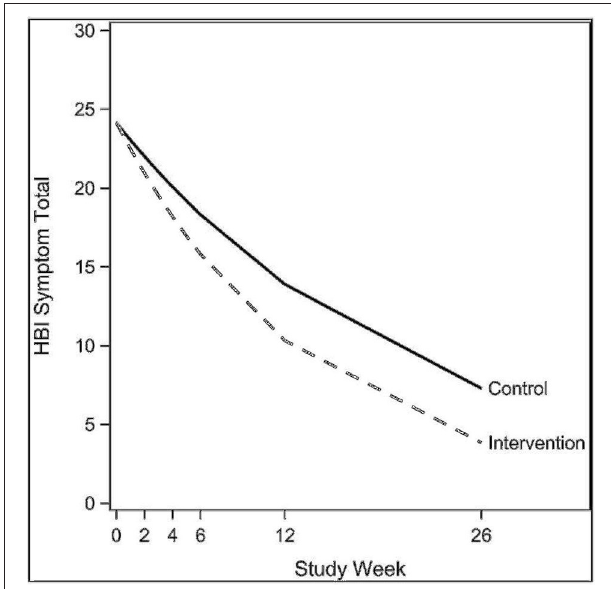
FIGURE 3 | Exponential decay models examining the effect of the Sub-Threshold Exercise Program (STEP) on concussive symptoms in youth, Seattle WA 2016–17.